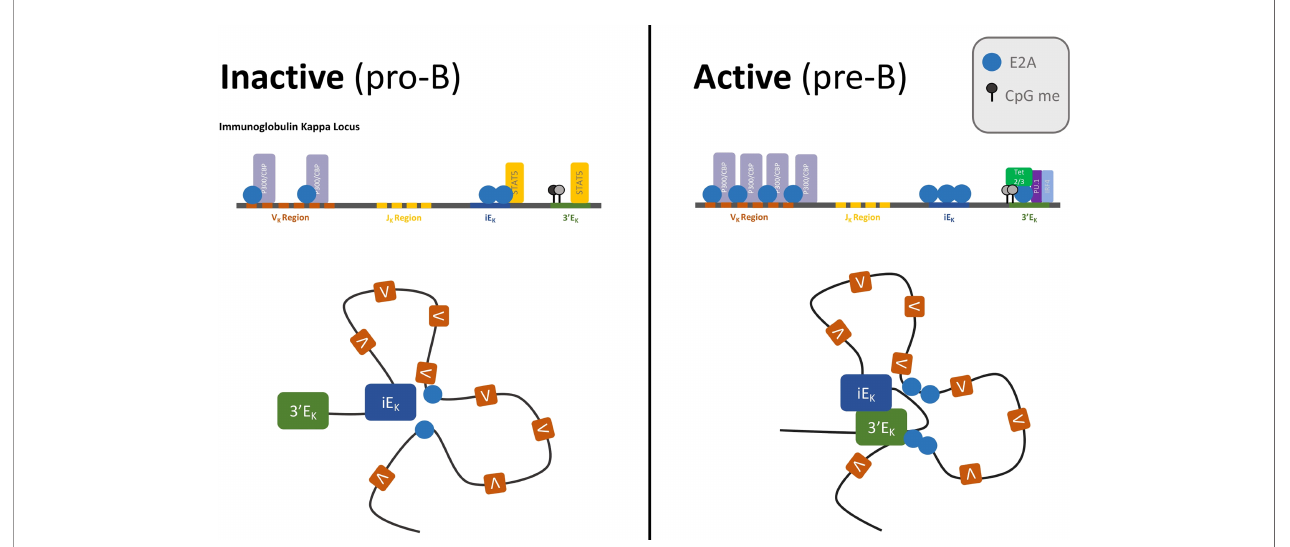
FIGURE 3 | Enhancer activation by E2A drives IgK recombination.The IgK locus is poised for recombination in pro-B cells — when E2A is bound to V K genes, V K regions have acetylated histone marks, and the locus is already contracted, with iE K making extensive contacts with the V K region. Activation of the locus coincides with E2A activation of the IgK enhancers. Pre-BCR signaling and IL-7/STAT5 attenuation render the iE K and 3 ’ E K enhancers insensitive to STAT5. E2A occupancy at the enhancers increases, and the Tet proteins are recruited to 3 ’ E K where they demethylate CpG residues. The now accessible 3 ’ E K enhancer forms extensive contacts with the V K